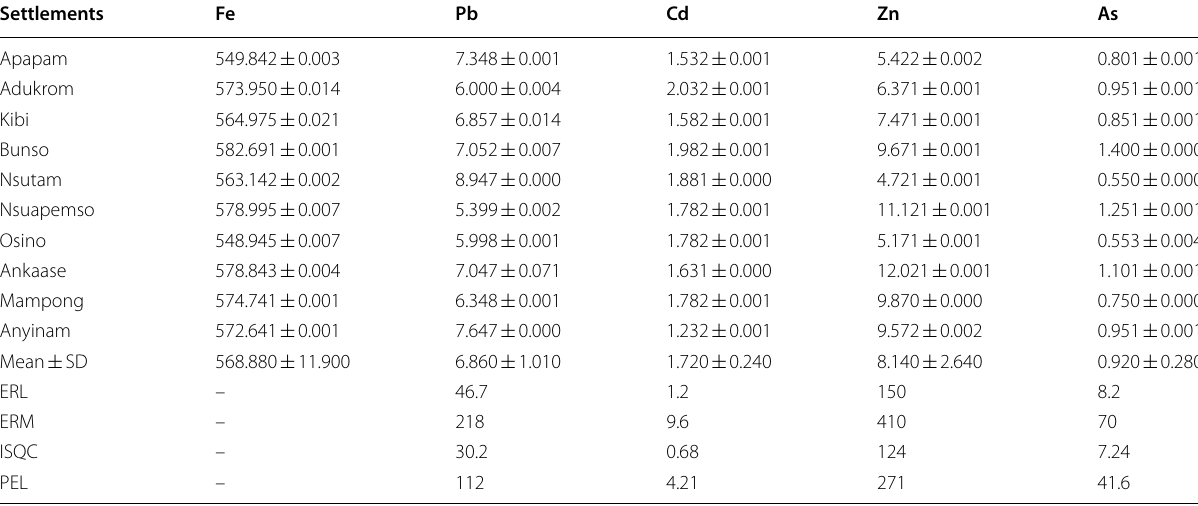
SD) in sediments from settlements within the Birim River basin ±